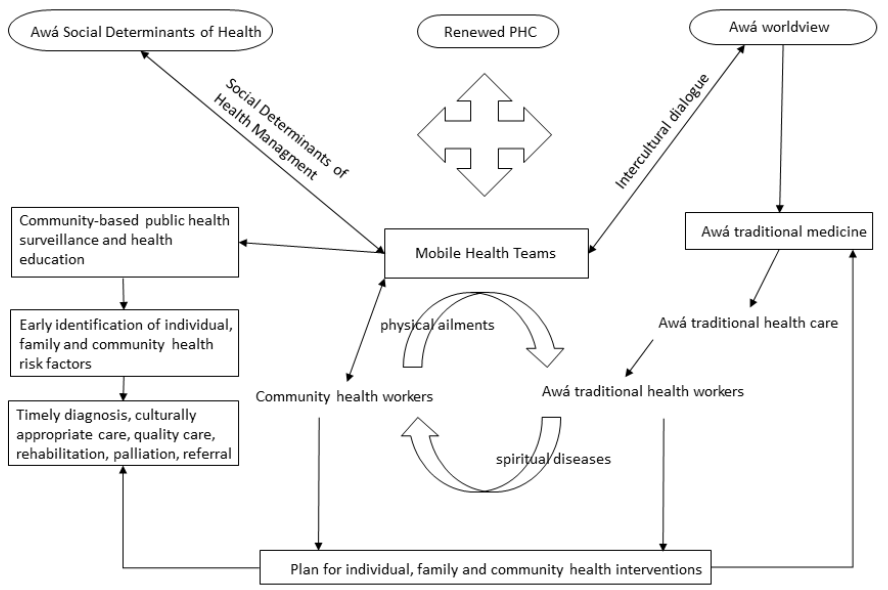
Figure 3. Concerted intercultural health care model. (Source: Authors’ own construction, based on the proposals of the qualitative field work and consultation with the Awá people).